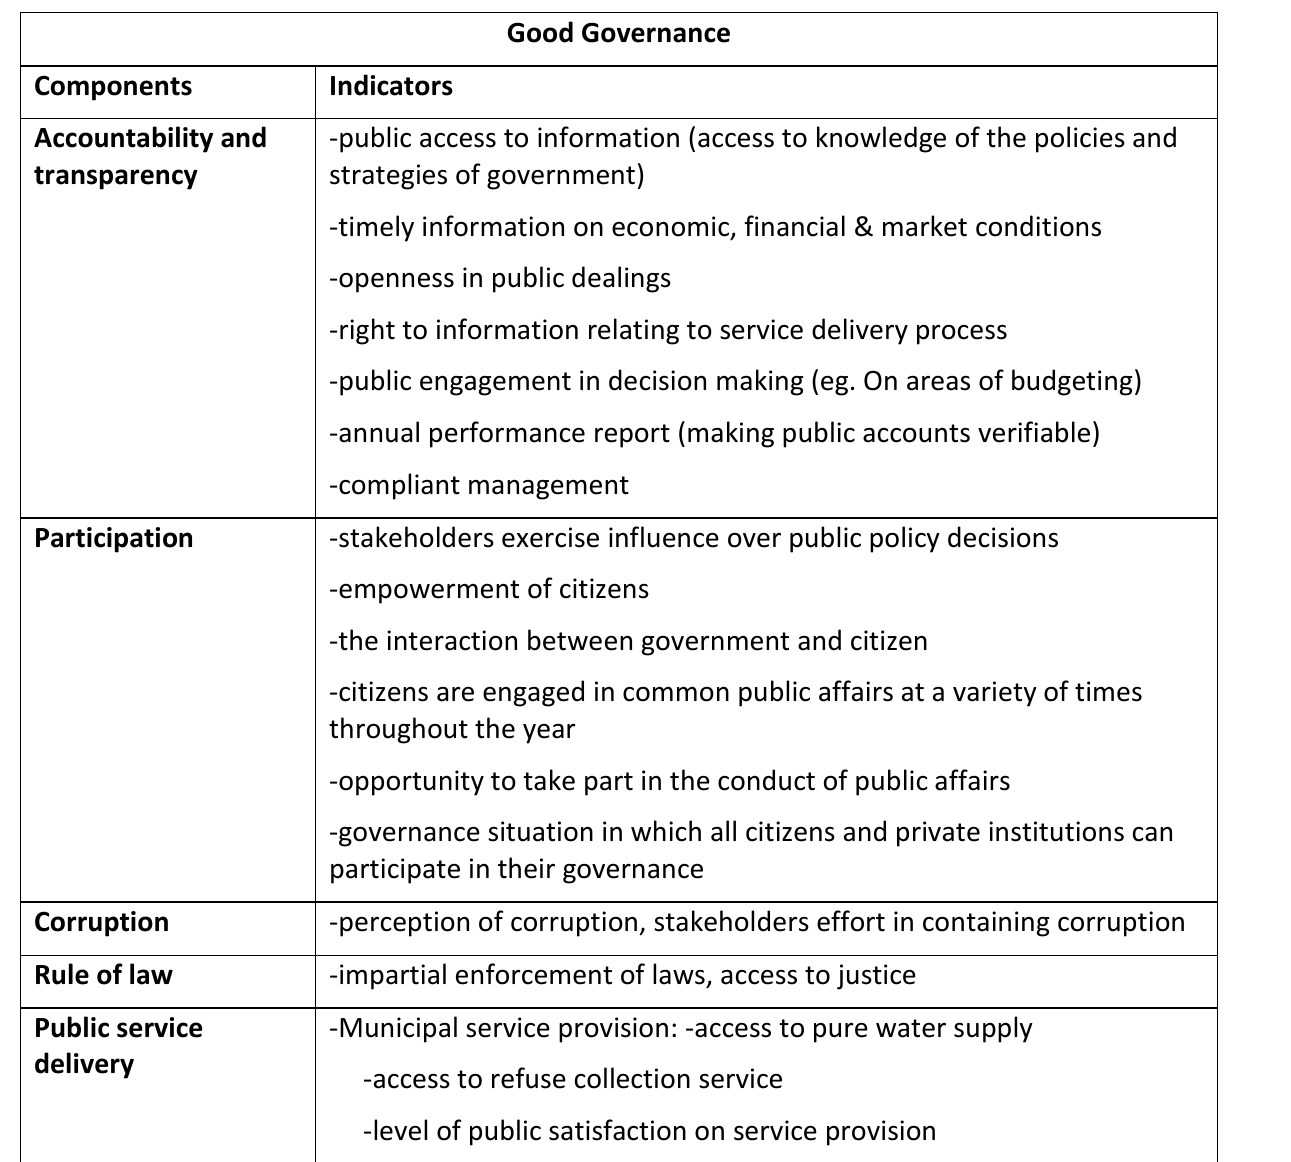
Table 1: Indicator framework of good governance